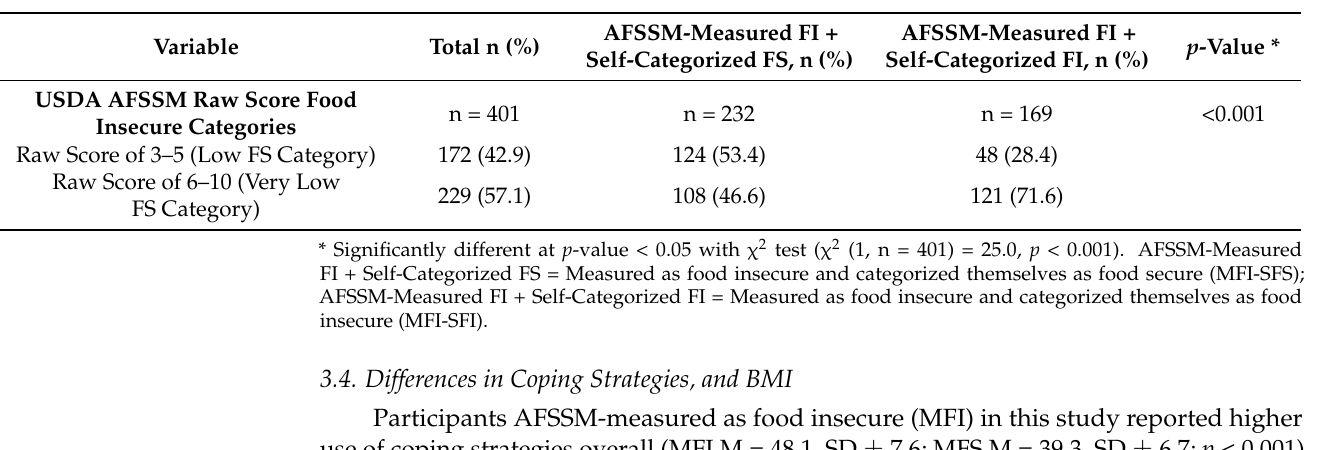
Figure 2. Raw Scores of USDA AFSSM by Self-Categorized Food Security Status among College Students AFSSM-Measured as Food Insecure (n = 401). USDA AFSSM = US Department of Agriculture 10-item Adult Food Security Survey Module; FI = Food Insecure; FS = Food Secure. Table 2. Differences in USDA AFSSM Raw Scores by Self-Categorized Food Security Status among College Students AFSSM-Measured as Food Insecure (n = 401).